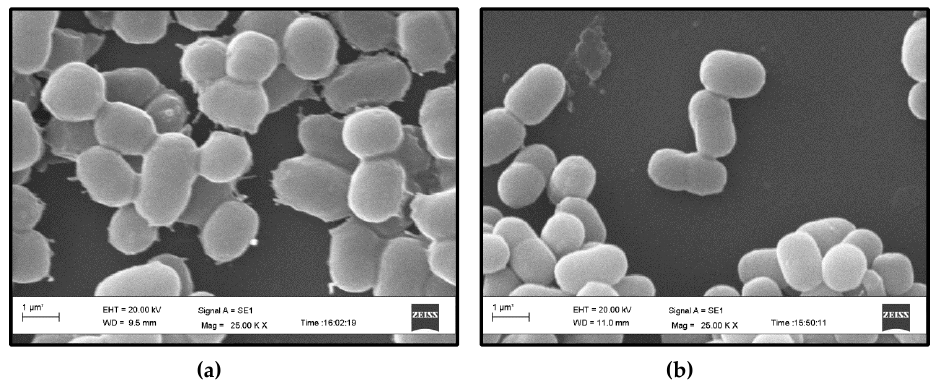
Figure 2. Scanning electron microscope analysis of: ( a ) Synechococcus sp. BDU 130192; ( b ) Synechococcus sp. PCC 7002.